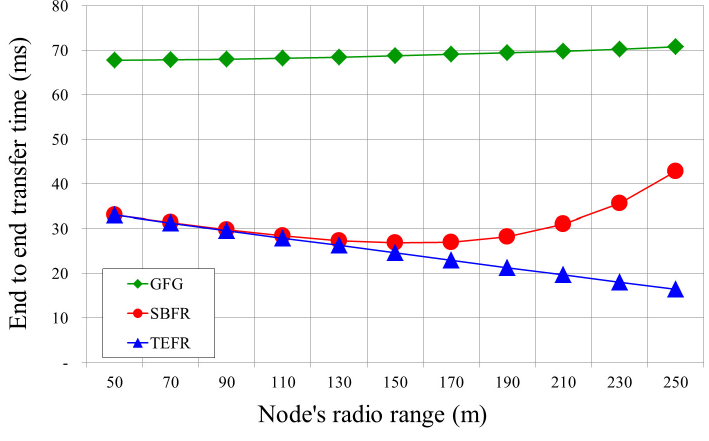
Figure 10. Transfer time according to the number of deployed nodes (radio range: 100 m).